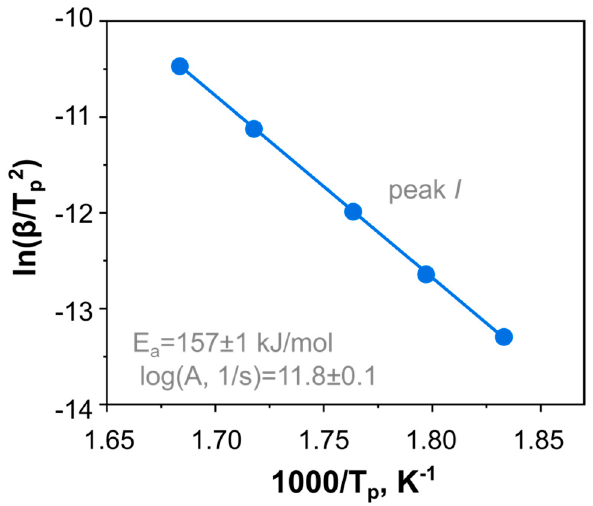
Figure 4. The Kissinger plot for the main peak ( I ) of DBT thermolysis under an elevated pressure of 2.0 MPa.